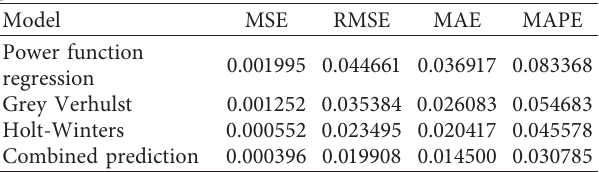
Figure 4: Comparison of combined prediction model forecast data and actual data. Table 7: Comparison of combination prediction model and single prediction models.